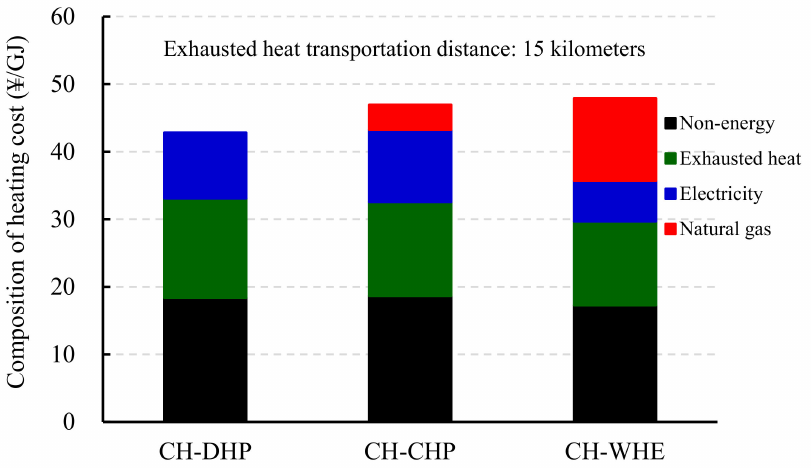
Figure 9. Compositions of heating